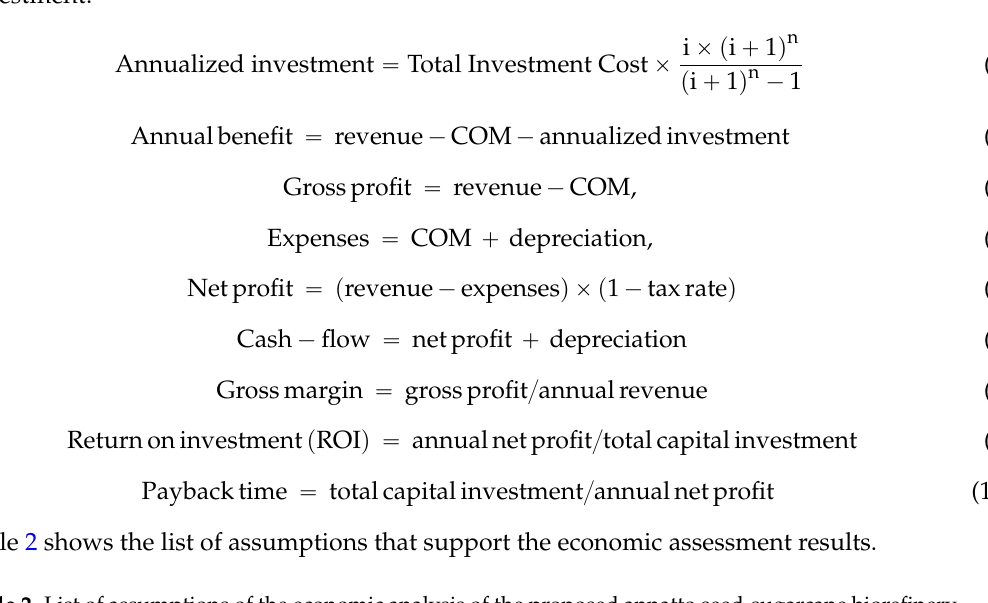
Table 2. List of assumptions of the economic analysis of the proposed annatto seed-sugarcane